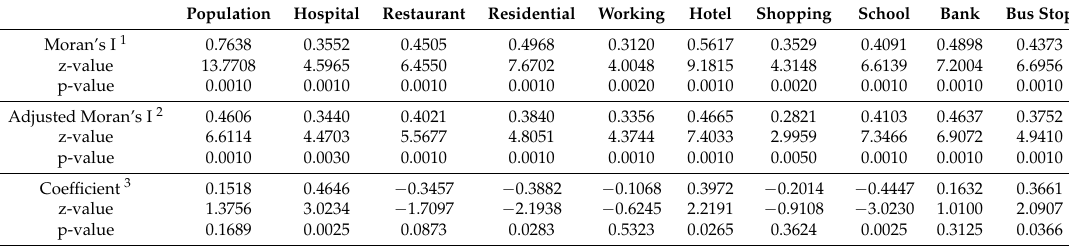
Figure 9. Hourly passenger volume in terms of in-station and out-station by weekdays for example stations in Type I, II, III, IV, V. Table 5. Spatial autocorrelation analysis results of environmental